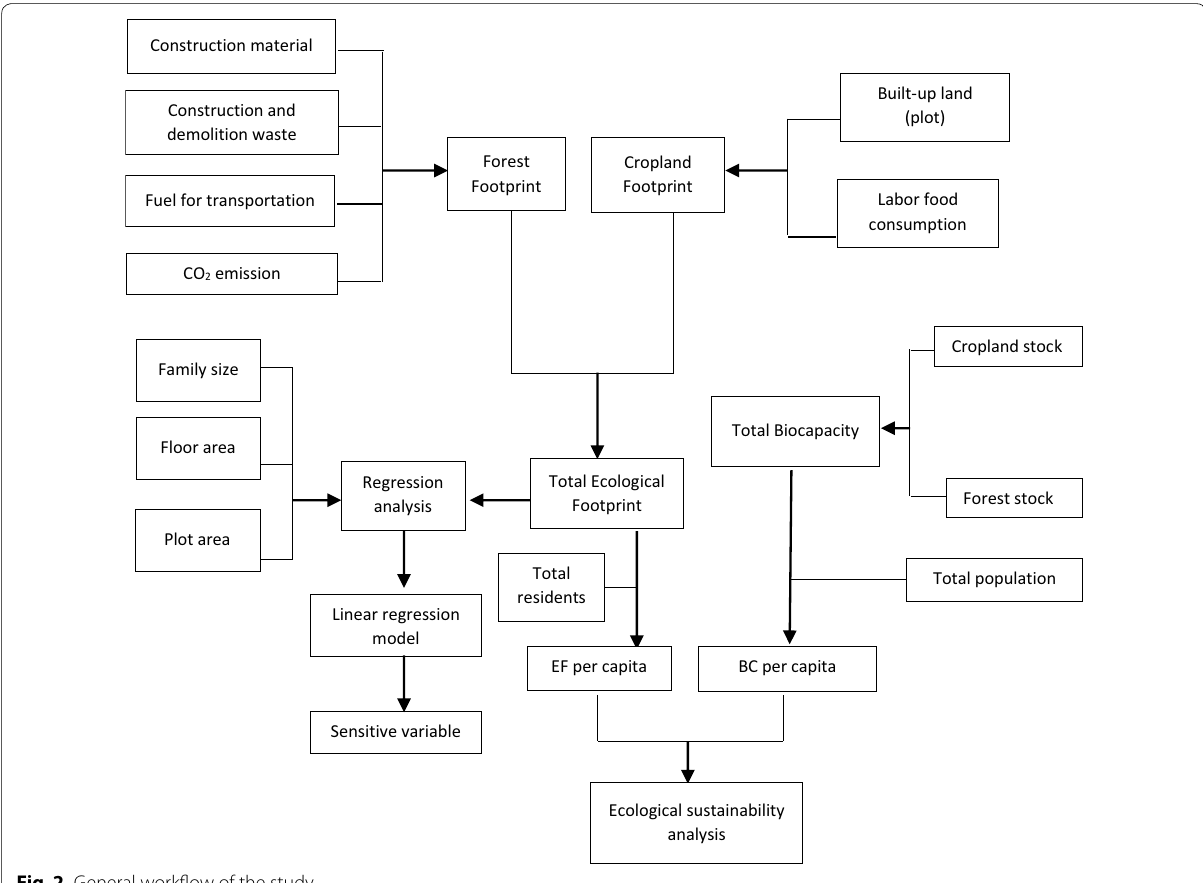
Fig. 2 General workflow of the